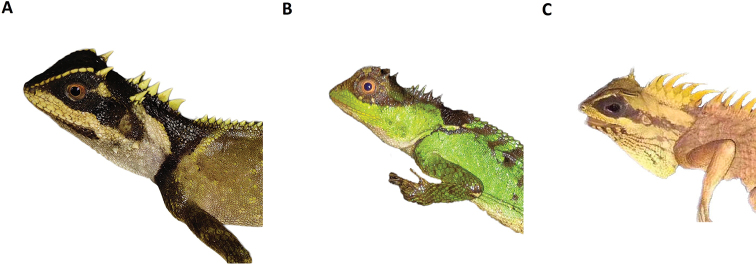
Comparison of three different types of eye patch AAcanthosaura
tongbiguanensis sp. nov. BA.
lepidogasterCA.
nataliae.